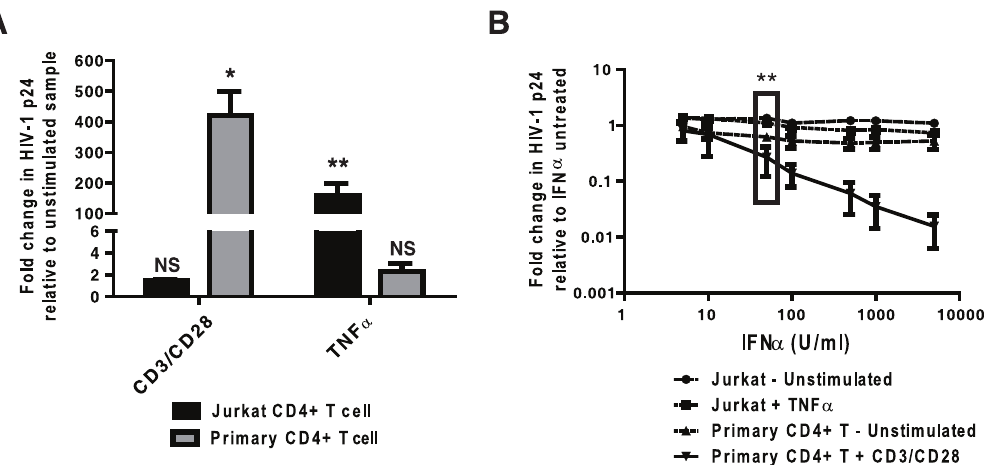
Figure 4. TNF a and IFN a affect HIV-1 replication in Jurkat and primary CD4 + T cells respond differently to HIV-1 stimulatory or inhibitory cytokines. HIV-1-infected Jurkat CD4 + T cells or primary CD4 + T cells were exposed to TNF a or T cell receptor crosslinking antibodies (A) or increasing concentrations of IFN a (B) or left untreated for 5 or 7 days respectively. Subsequently, the level of HIV-1 replication was quantified by ELISA for p24 antigen. Data represent the mean 6 s.e.m. of a minimum of 3 separate experiments with the amount of HIV-1 replication expressed as the percentage of p24 antigen compared to unstimulated/untreated samples. Significant differences are represented by comparison with the following legend: *p # 0.05, **p #